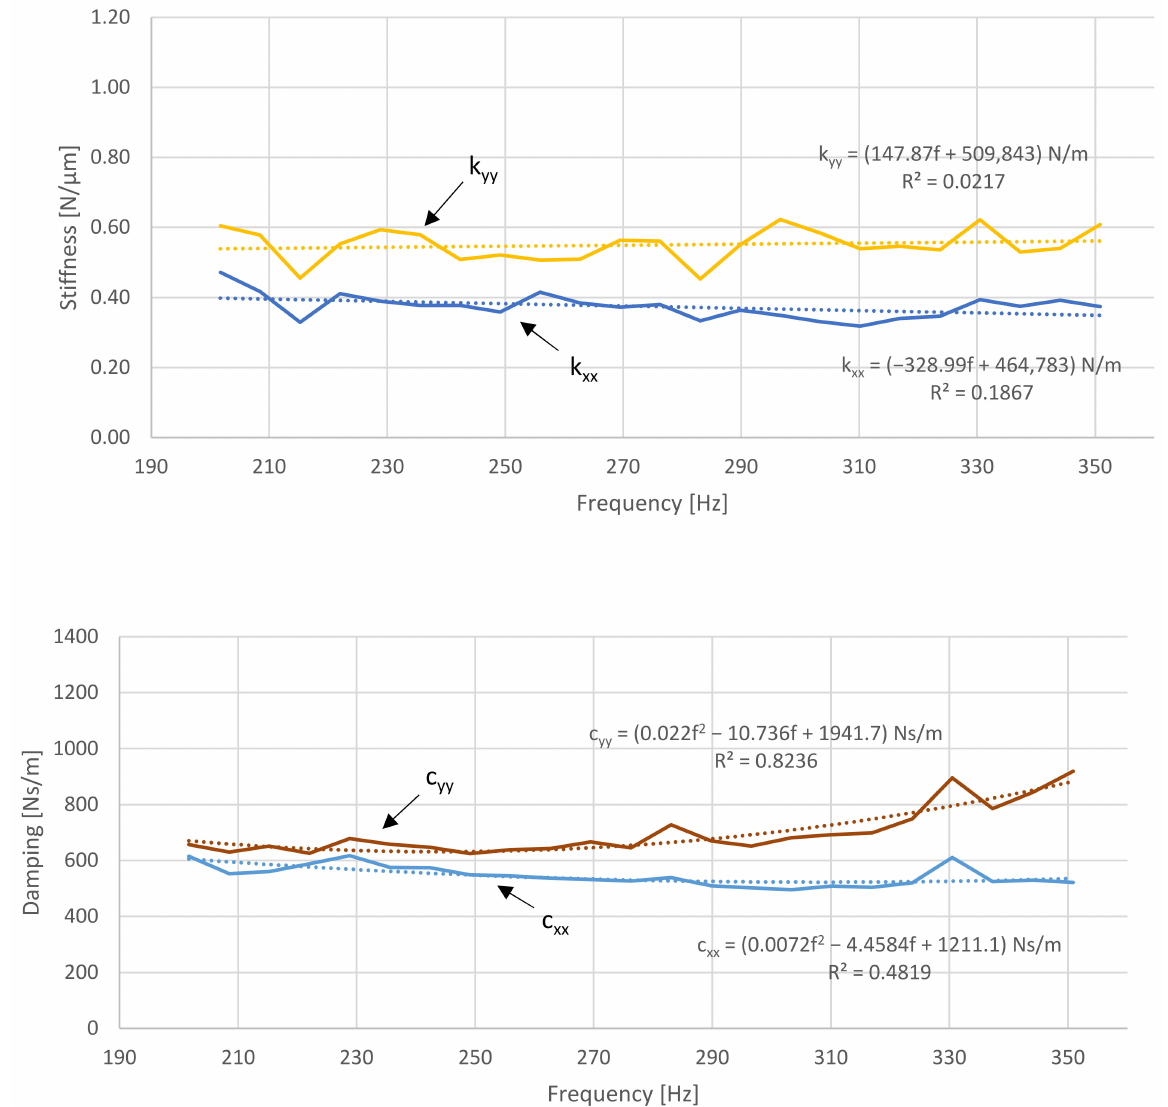
Figure 9. Dynamic coefficients with friction factors below 25% (200 Hz–350 Hz); 15 N dynamic force amplitude; 11.1 N static